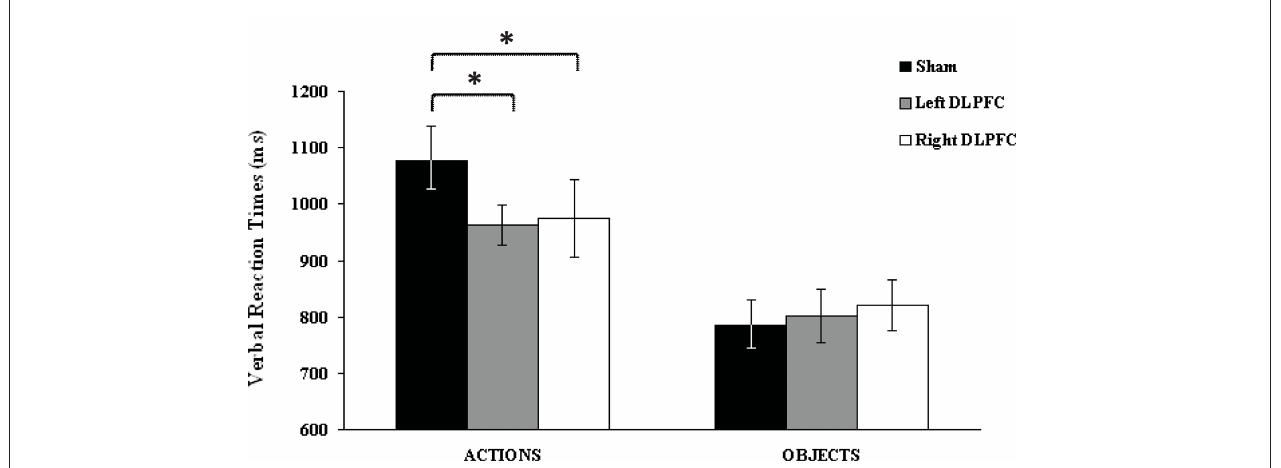
FiguRE 2 | verbal reaction times (vRTs) following each stimulation condition, plotted separately for action and object stimuli. Asterisks indicate significant effects ( p < 0.05). vRTs for actions were consistently faster during left and right dorsolateral prefrontal cortex than during sham stimulation. No significant differences were observed for object naming. Errors bars indicate mean standard